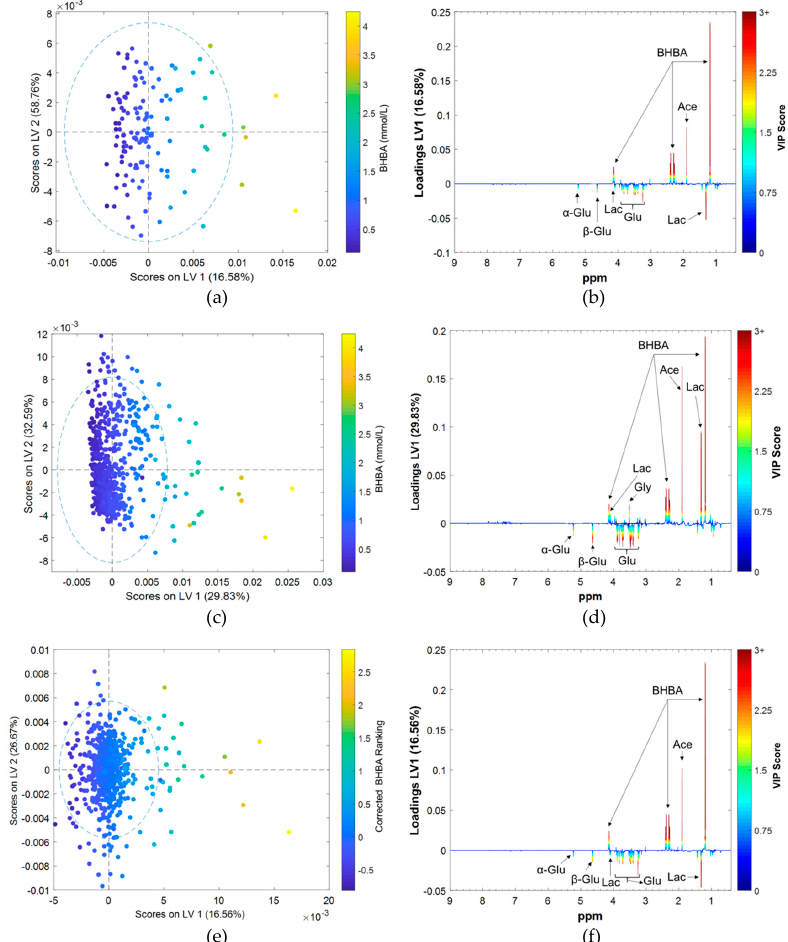
Figure 5. Results of OPLS regressions of serum BHBA concentration against 1 H NMR spectrum of bovine serum: ( a ) Farm 1 (N = 179) LV1 vs. LV2 scores and ( b ) LV1 loadings, ( c ) all farms (N = 707) uncorrected data LV1 vs. LV2 scores and ( d ) LV1 loadings, and ( e ) all farms data LV1 vs. LV2 scores and ( d ) LV1 loadings.